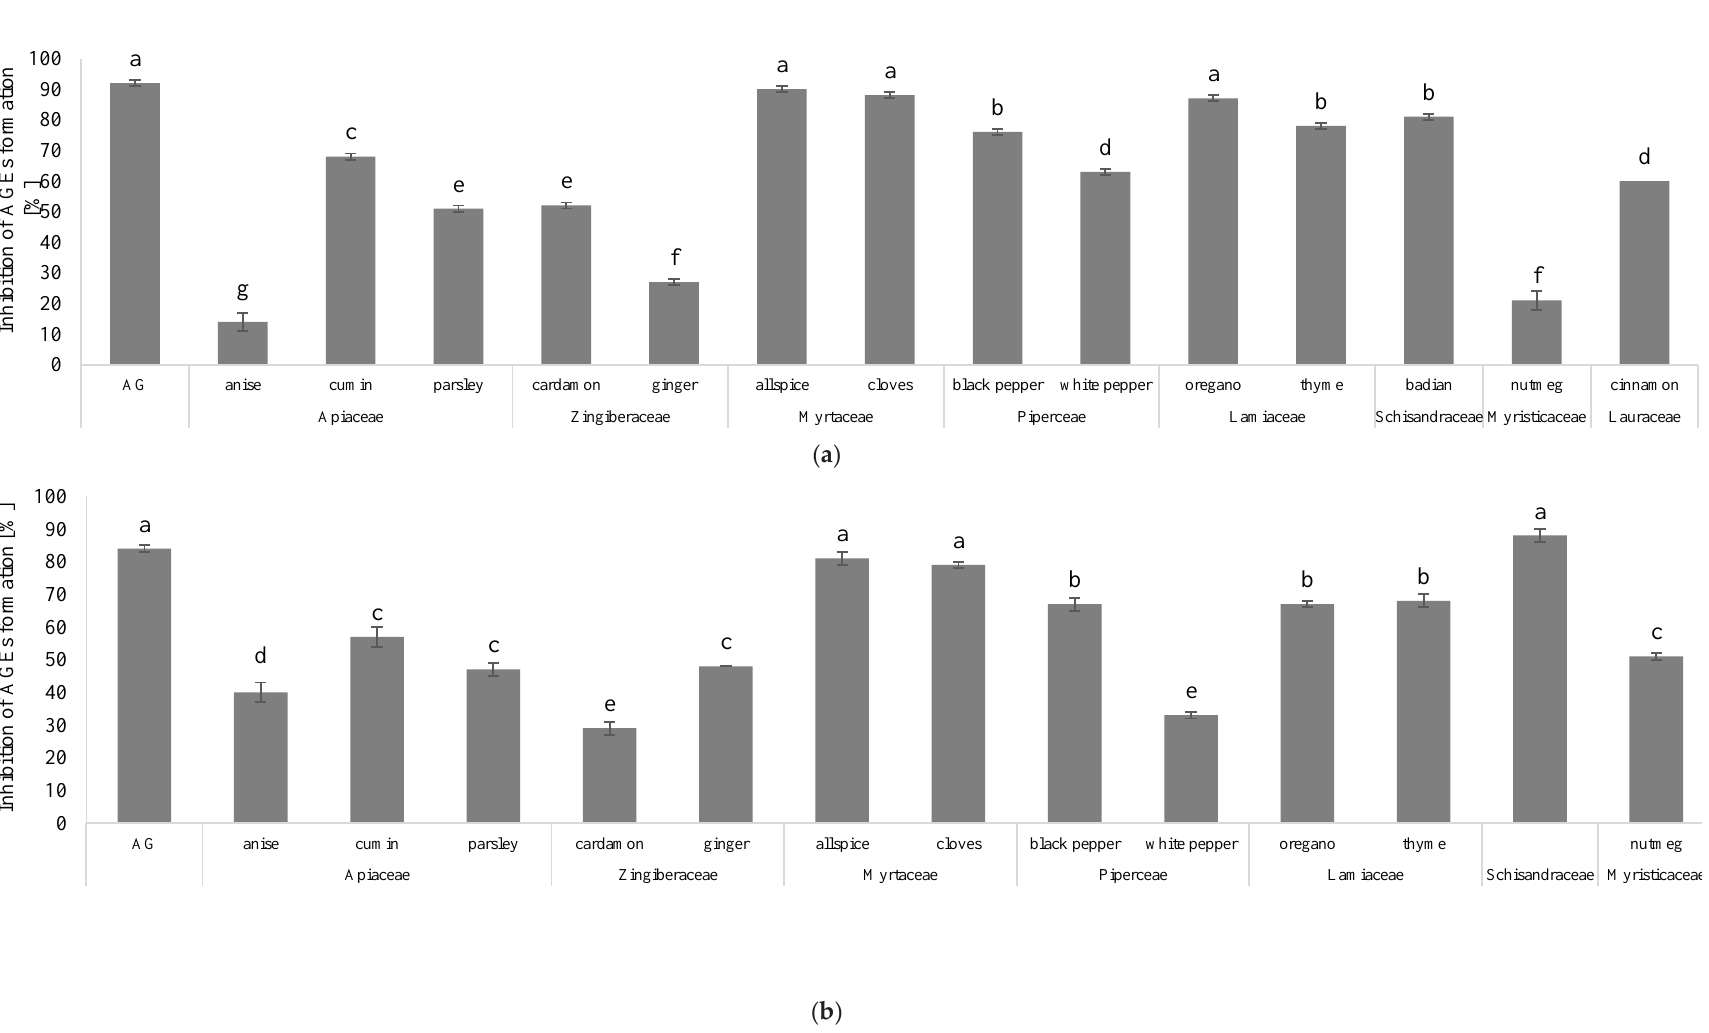
Figure 1. The ability of spices and herbs’ extracts to inhibit AGEs formation measured in ( a ) BSA-glucose and ( b ) BSA-MGO model systems. AG: aminoguanidine; AGEs: Advanced Glycation End- products.